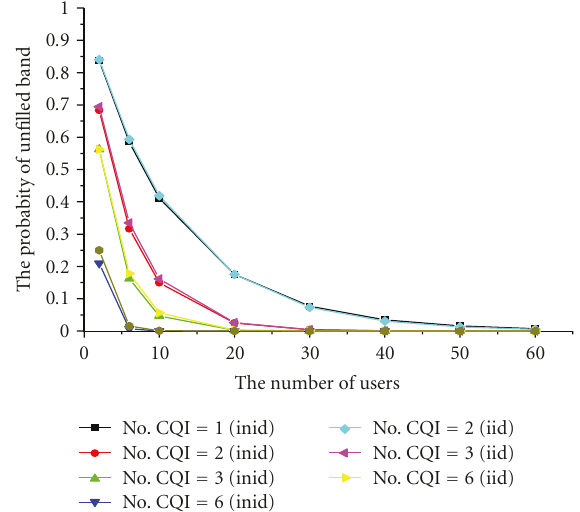
Figure 6: The probability of unfilled band: L = 3 .